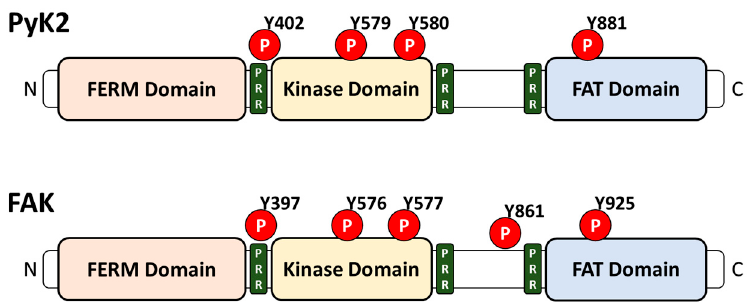
Figure 1. Schematic structure of PyK2 and FAK. Similar structures of PyK2 and FAK, both of which contain a FERM domain, kinase domain, and FAT domain, from the N-terminal (N) to the C- terminal (C). PyK2 and FAK contain a proline-rich region (PRR) and a phosphorylation site